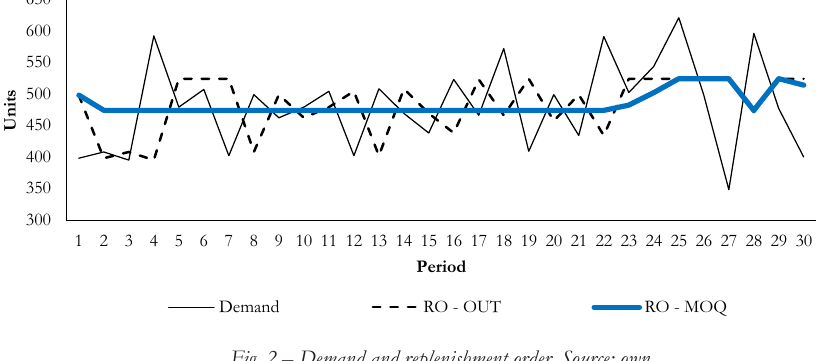
Fig. 2 – Demand and replenishment order. Source: